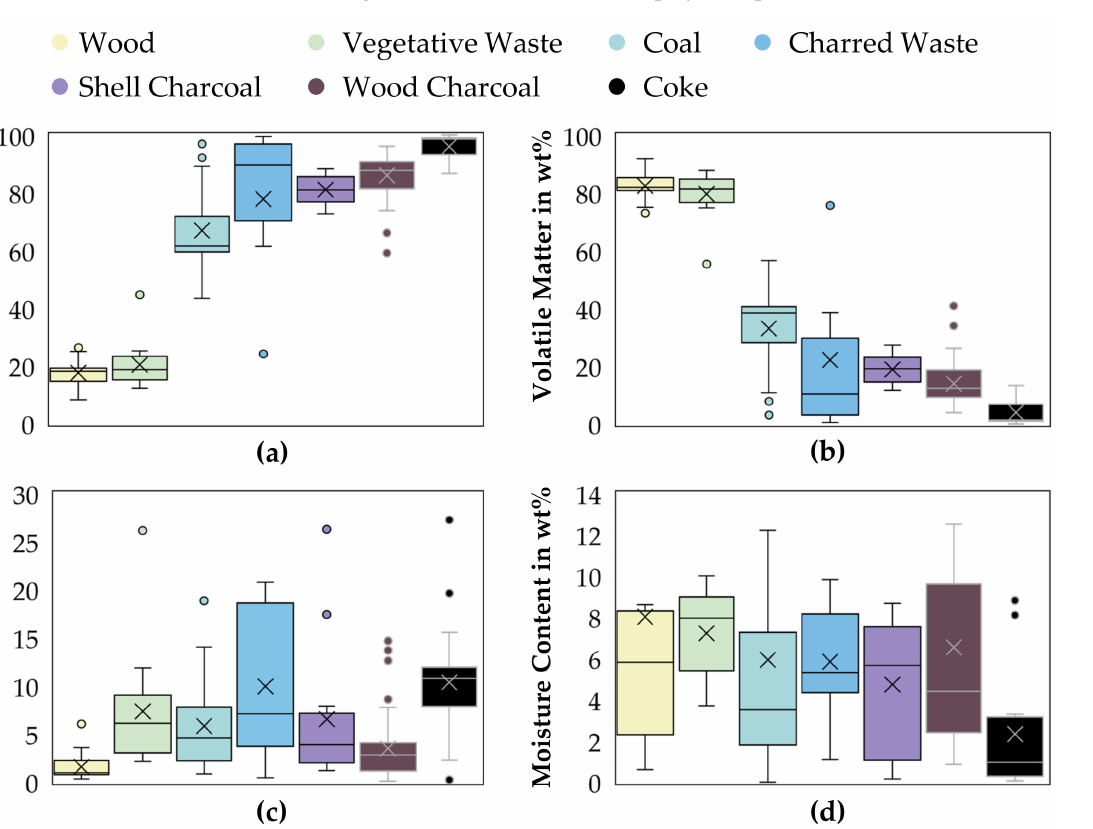
Figure 3. Box plots of parameters obtained by proximate analysis of different reducing agents sorted by ascending fixed carbon content. ( a ): Fixed carbon, dry and ash-free. ( b ): Volatile matter, dry and ash-free. ( c ): Ash content, as received. ( d ): Moisture content, as